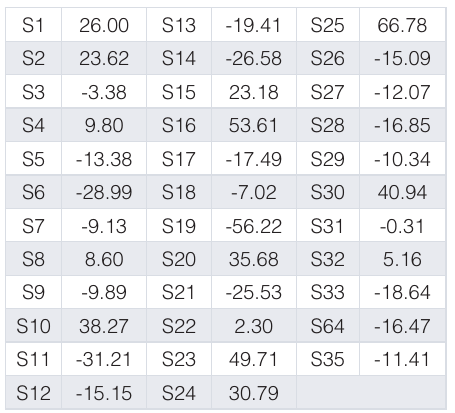
in median reaction times, used for Figure 1 and testing (Fisher, Neyman-Pearson, Equivalence testing, Bayes